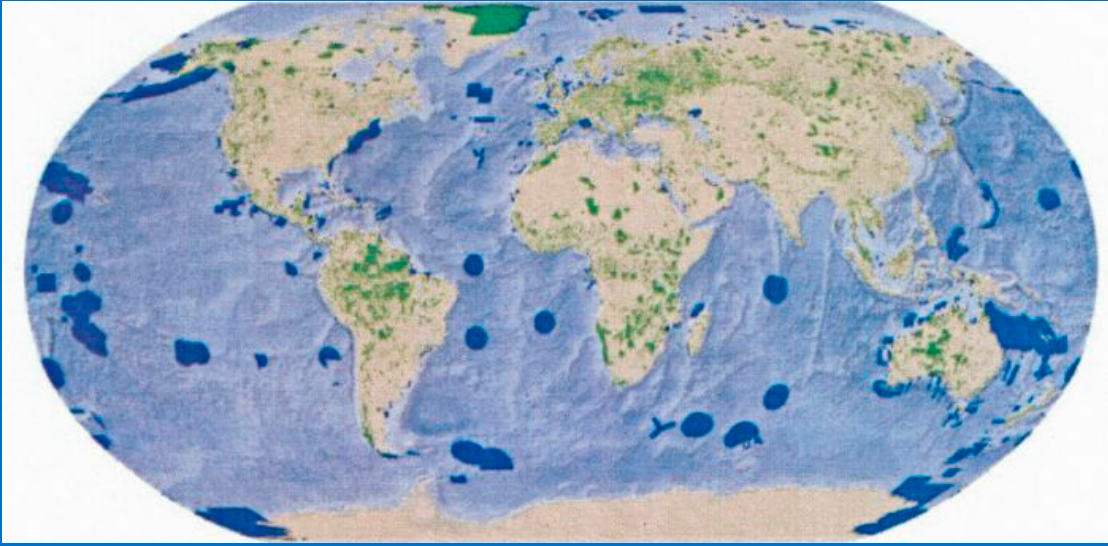
Figure 13. Protected Areas UNRP-WCMC, 2018. Terrestrial areas—green; marine and coastal ar-